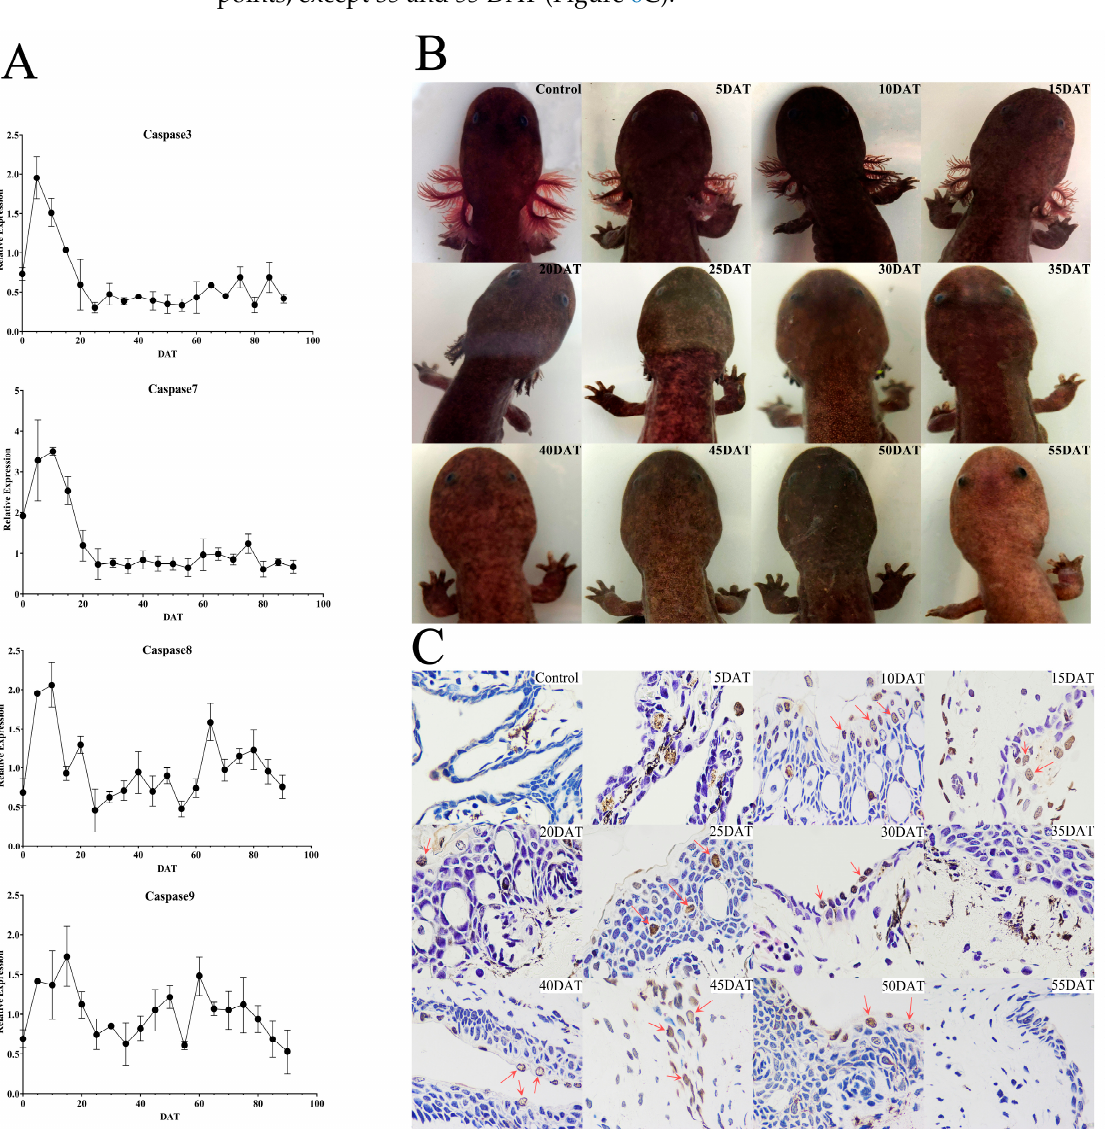
Figure 6. Results after the TH treatment for 7-MOA Chinese giant salamanders sampled every 5 DAT. ( A ) The expression trends of caspases 3/7/8/9 in the external gills of the Chinese giant salamanders after the TH treatment. ( B ) Trends in external gill morphology of the Chinese giant salamanders after the TH treatment. ( C ) Apoptosis in the external gills of the Chinese giant salamanders after the TH treatment, as seen using a TUNEL assay (400 × ). Red arrows indicate TUNEL-positive